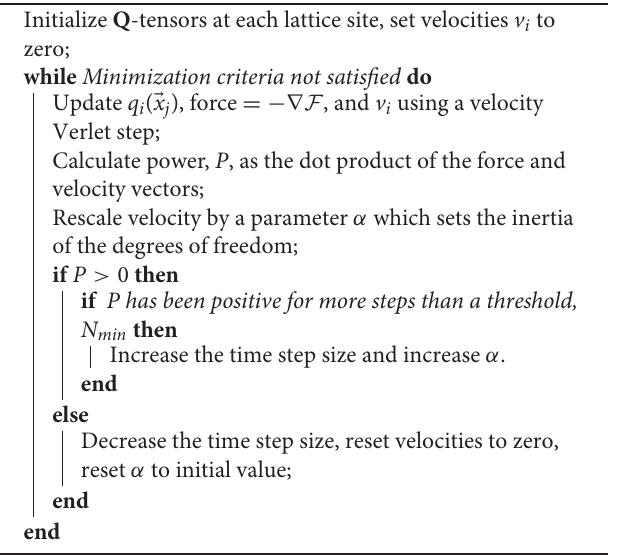
Algorithm 1: Pseudocode for FIRE minimization [81].